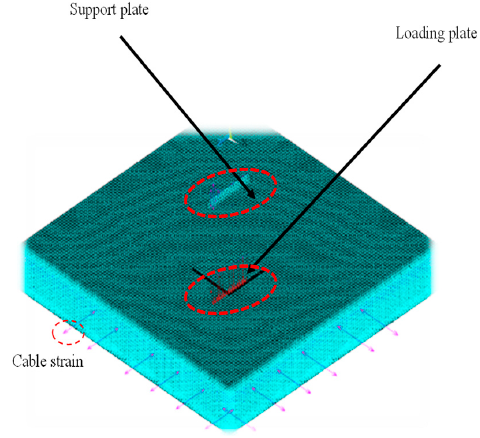
Figure 12. Loading and support locations.